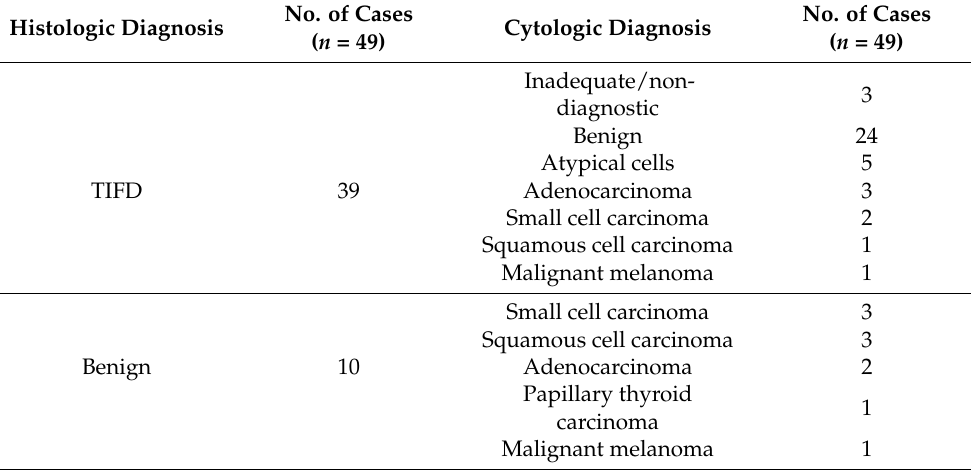
Table 5. Cytologic diagnoses of tissue sampling error